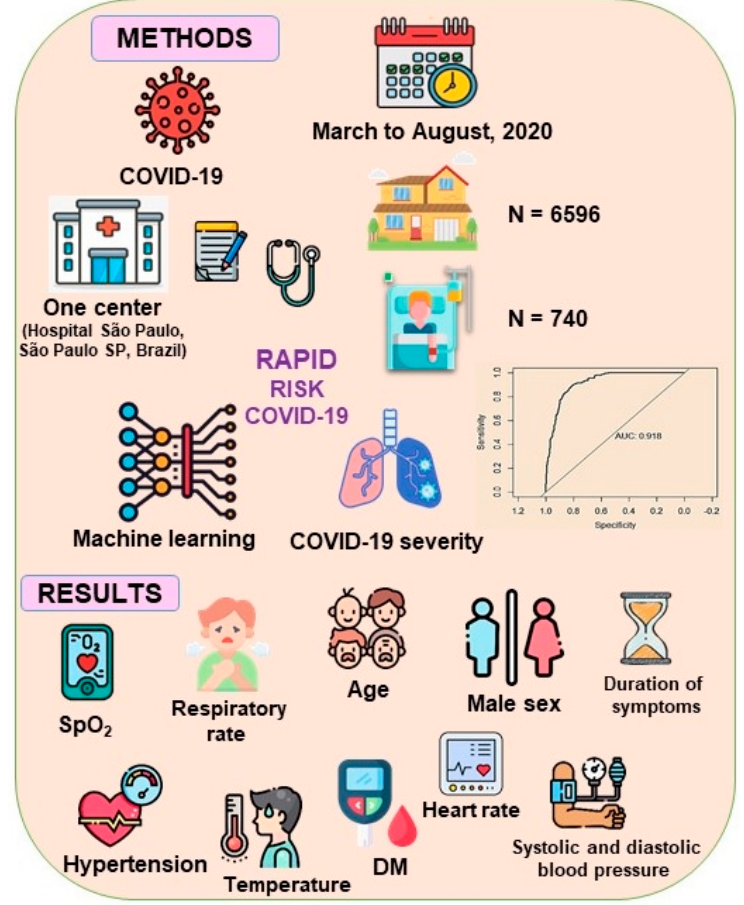
Figure 3. Summary of the study design and findings.